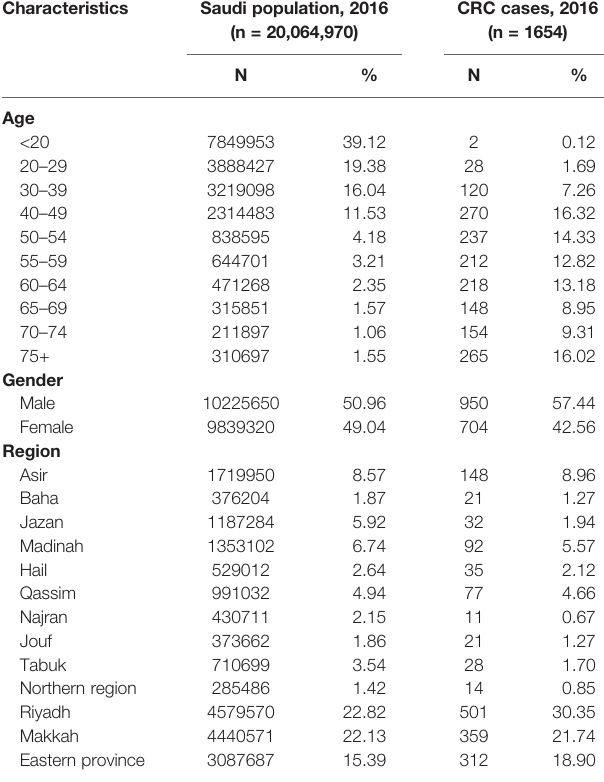
TABLE 1 | Characteristics of the Saudi population and the population-based colorectal cancer cases, Saudi Arabia, 2016.